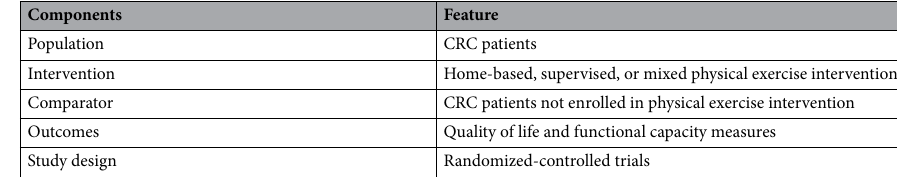
Table 1. Eligibility criteria for inclusion of studies in this systematic review according to the PICOS (population, intervention, comparator, outcomes, and study design) criteria. CRC colorectal